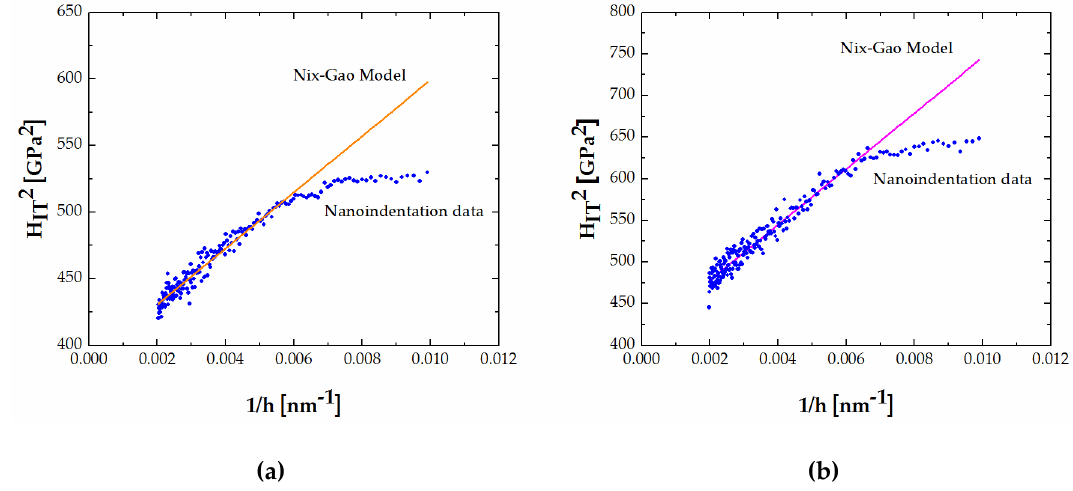
Figure 13. H IT2 vs. h − 1 plot: ( a ) FeB in 39.7 Fe–33 B–27.3 C, and ( b ) Fe 2 B in 50 Fe–41 B–9 V (alloy 14).